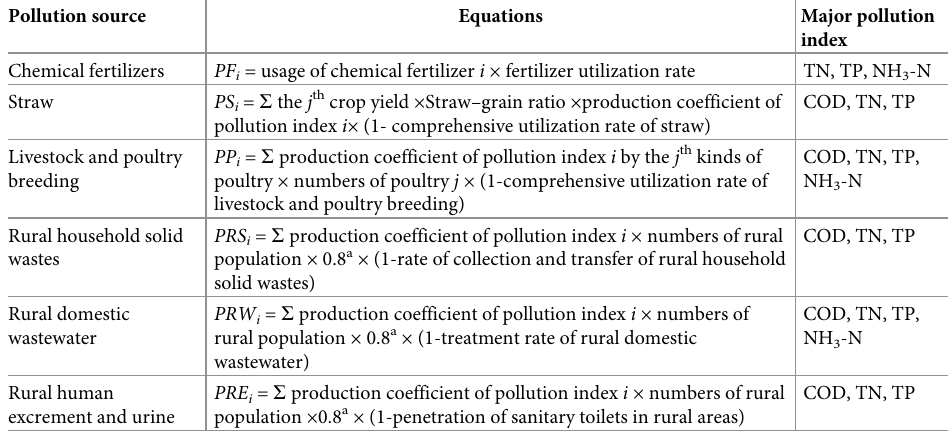
Table 1. Equations used for estimating the potential pollution of different sources.